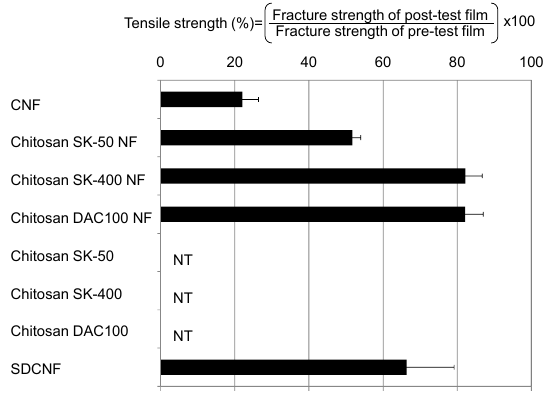
Figure 3. Tensile strength of sheets after the antifungal test. The sheets were harvested from agar plates after the antifungal test and their fracture strength was measured. Data represent the mean of three independent experiments with all five pathogens, and error bars indicate standard error. NT, not tested; CNF, chitin NF; SDCNF, surface-deacetylated CNF.